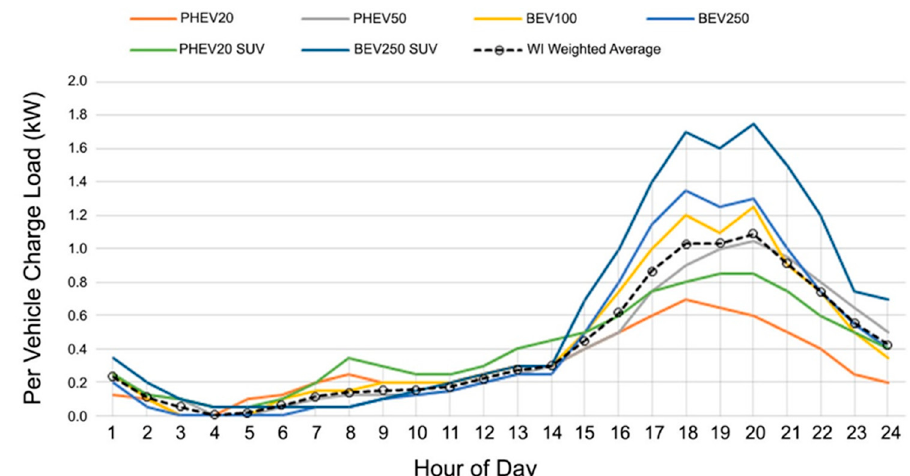
Figure 4. Daily charging load profiles for six vehicle categories, data from [23]. A single charging profile curve was determined by weighting these six profiles with the current share of vehicles registered in Wisconsin.